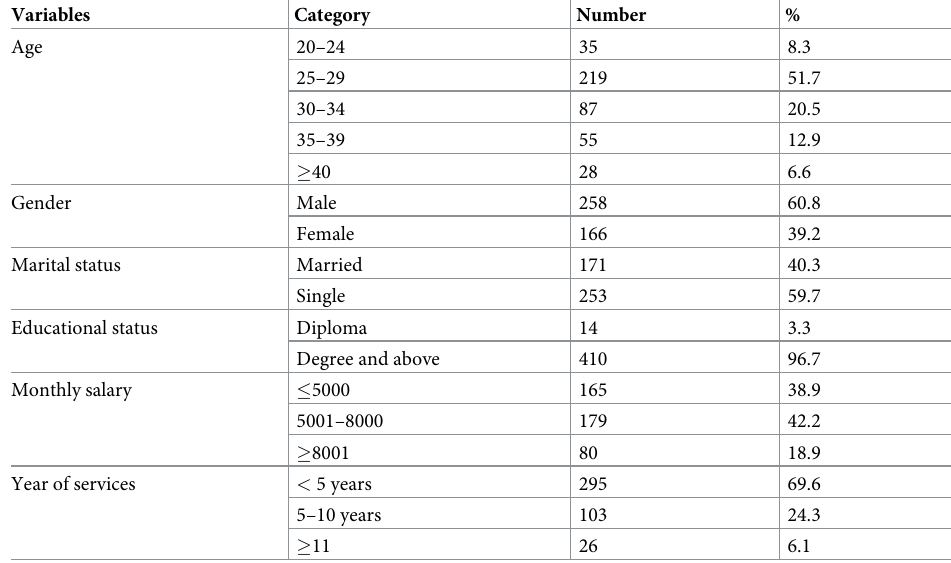
Table 1. Socio-demographic characteristics of midwives working in government health institutions of Addis Ababa city, Ethiopia, 2020.